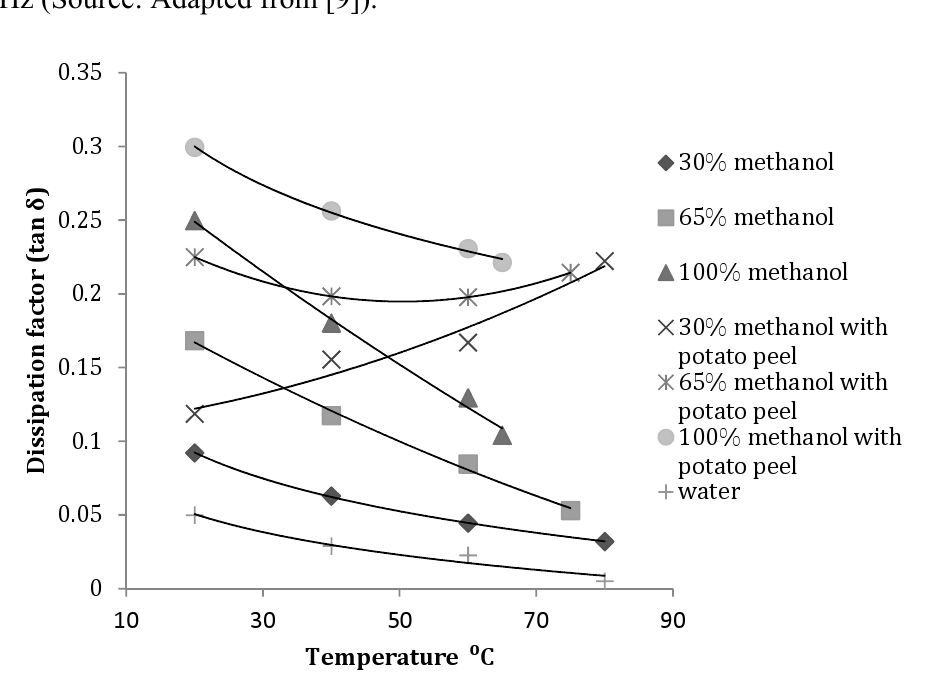
Figure 7. Dissipation factor of methanol-water mixture with and without potato peel at 915 MHz (Source: Adapted from [9]).